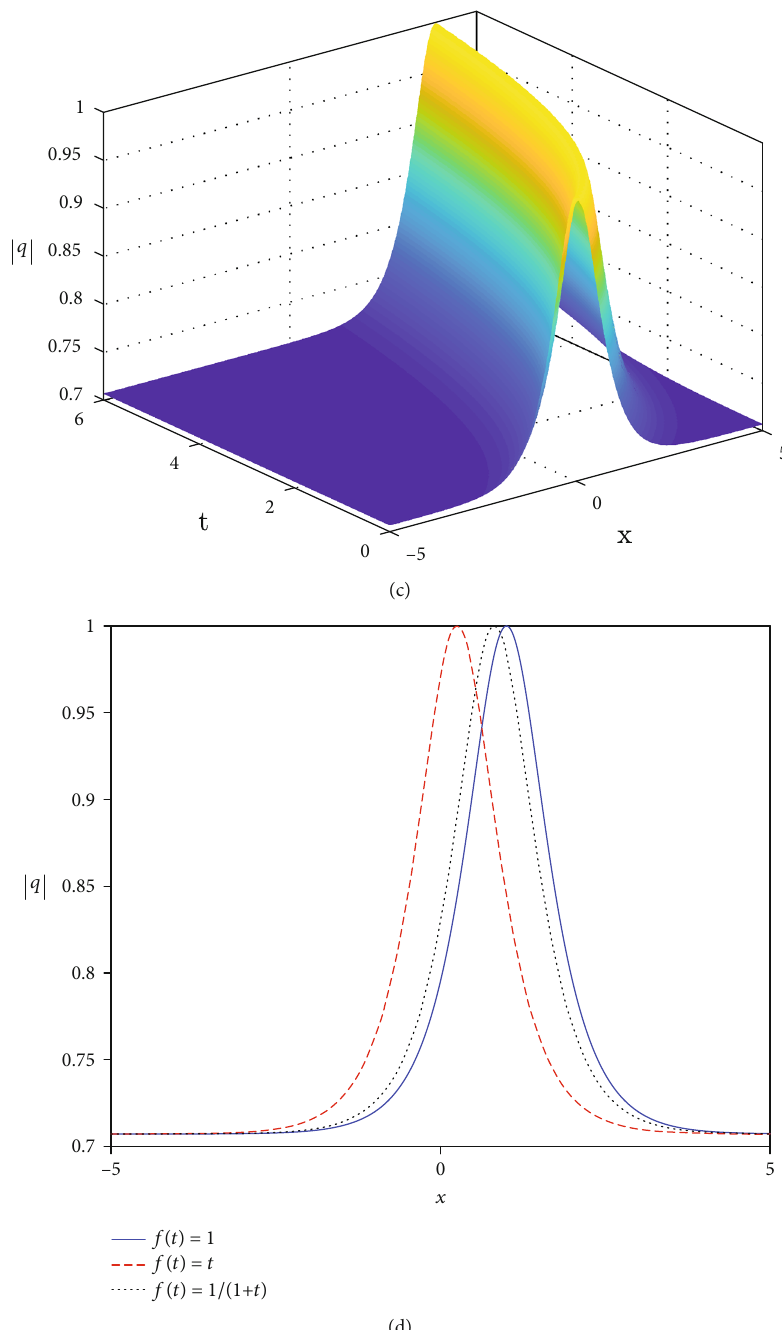
Figure 4: (a – c) The 3D wave shapes of j q j : (a) f ð t Þ = 1 , (b) f ð t Þ = t , and (c) f ð t Þ = 1/ ð 1 + t Þ . (d) The wave propagates along the x